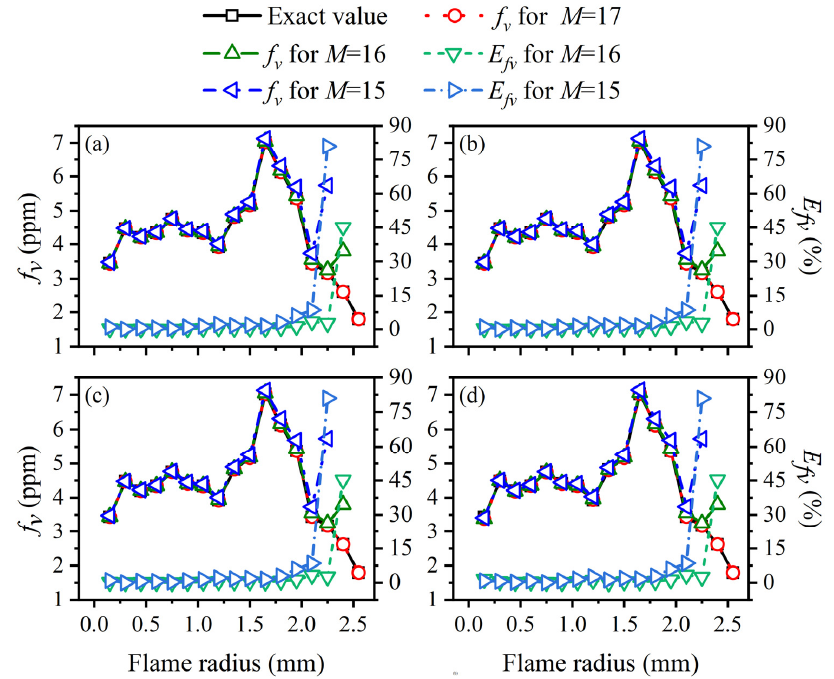
Figure 8. The reconstructed soot volume fraction and corresponding relative reconstruction error under different cases of SNR considering the edge effect. ( a ) SNR = 80 dB; ( b ) SNR = 65 dB; ( c ) SNR = 60 dB; ( d ) SNR = 46 dB.